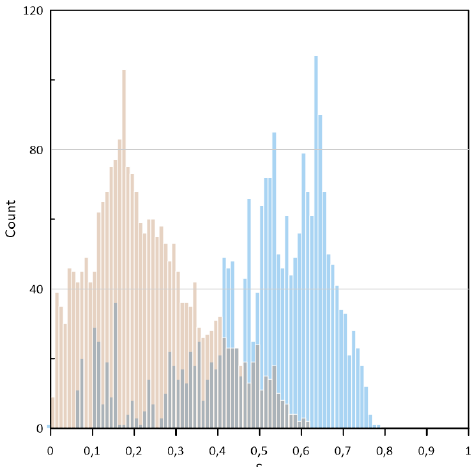
Figure 2. Probability distribution of modelled normalized soil moisture, separated into dry and wet seasons (brown and blue,